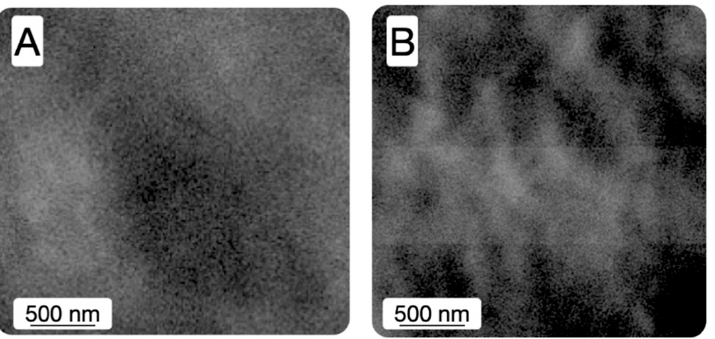
Figure 10. The mean ( A ), standard deviation ( B ), and variation coefficient ( C ) values for the varia- tion-rotational pictures obtained from the SEM images under the different magnification levels (2.5 k; 10 k; 15 k, and 20 k). (INI—initial sample at 20k magnification; others—modified, different magnification). The red ellipse and yellow and green circles are explained in the text.